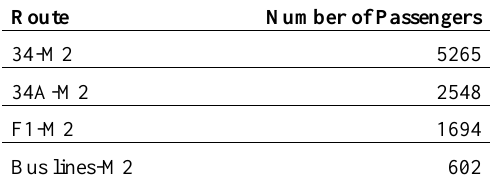
Table 5. Hourly number of passengers interchanging to subway line M2 on the listed routes.